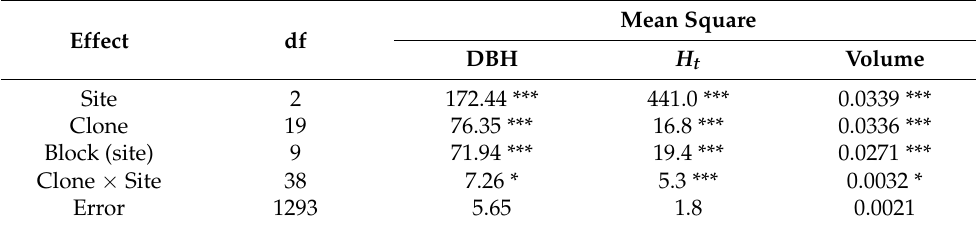
Table 4. Multisite ANOVA for the growth traits of the